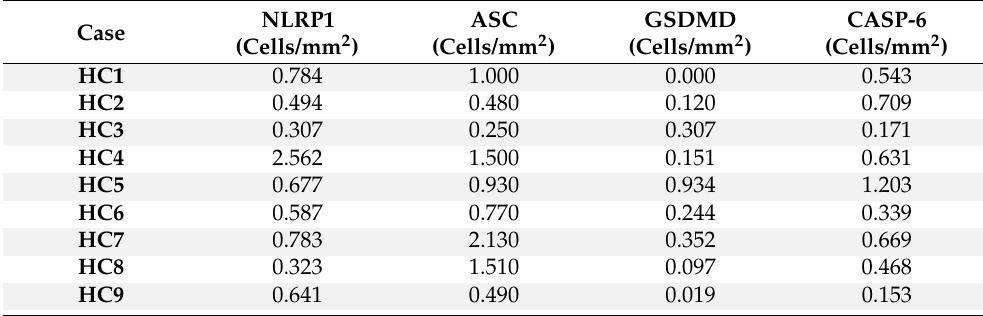
Table 3. Densities of immunoreactive neurons for the four different markers per mm 2 of hippocampal formation tissue .